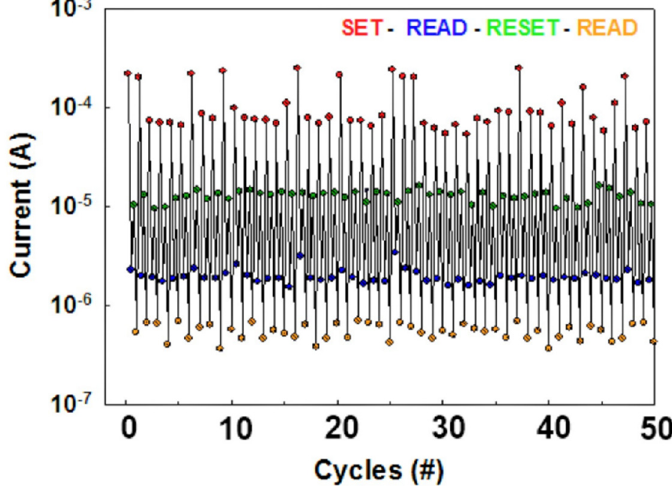
Figure 9. Pulse endurance property of the Au / Ni / SiO x N y / p + -Si memory device.